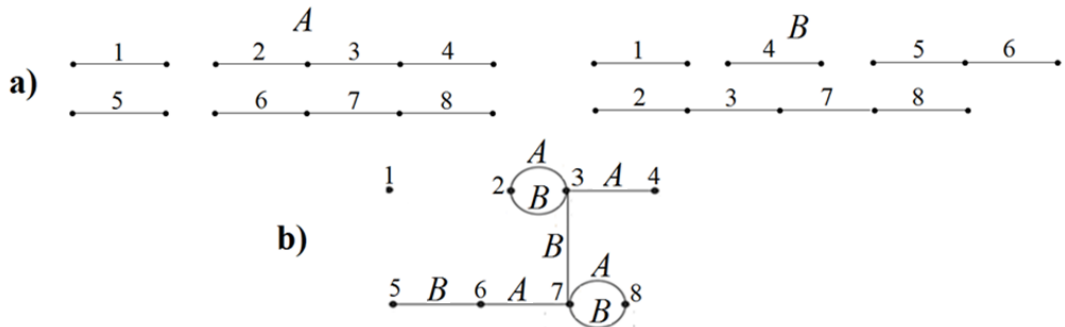
Figure 3. ( a ) Undirected structures A and B. ( b ) Their graph A * B . In A * B , a vertex can be incident to two A -edges and two B -edges (it’s a -degree and B -degree are 2). If we keep only A -edges and vertices nonincident to them, we obtain a weighted graph A’ consisting of two isolated vertices 1 and 5, and two paths 2-3-4 and 6-7-8. If we replace each vertex in A’ by an undirected edge with the same name and join endpoints of new edges according to edges in A’ , we obtain the original structure A . Similarly, from B’ we obtain the structure B .